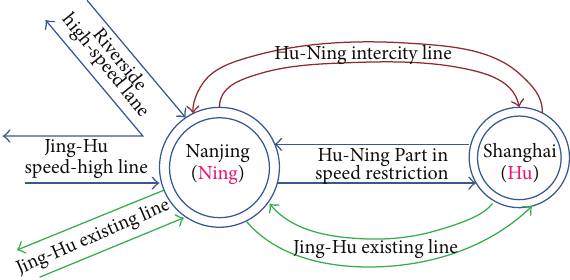
Figure 5: The railway network around Nanjing